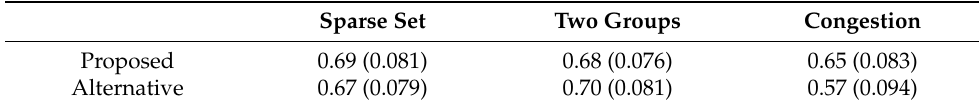
Table 2. Mean number of pointing gestures with standard